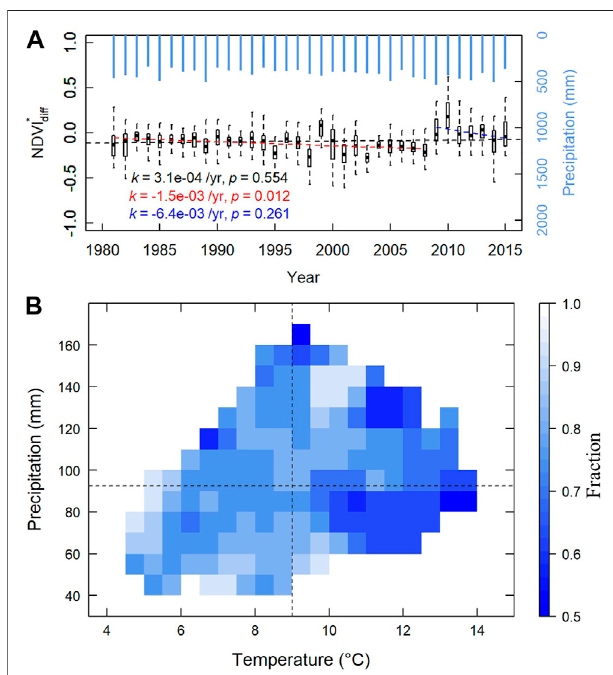
FIGURE5| TrendandsensitivityofgrazingimpactsonAugustNDVI. (A) Inter-annual trend of August NDVI * diff ; (B) Percentage of negative S n distributed in August climate space (with 0.5 ℃ temperature interval and 10 mm precipitation